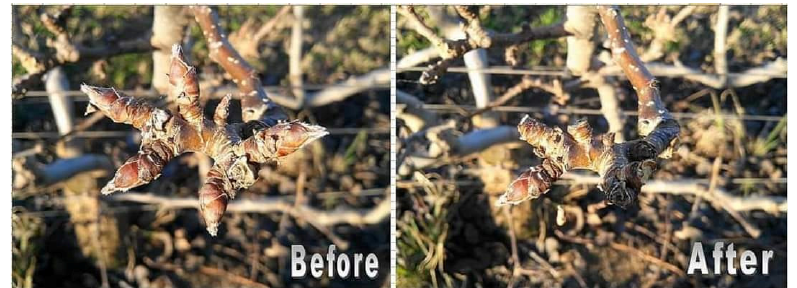
Figure 4. Bud thinning in nashi. Photo credit: Steven Singh, Seeka Australia Pty Ltd.